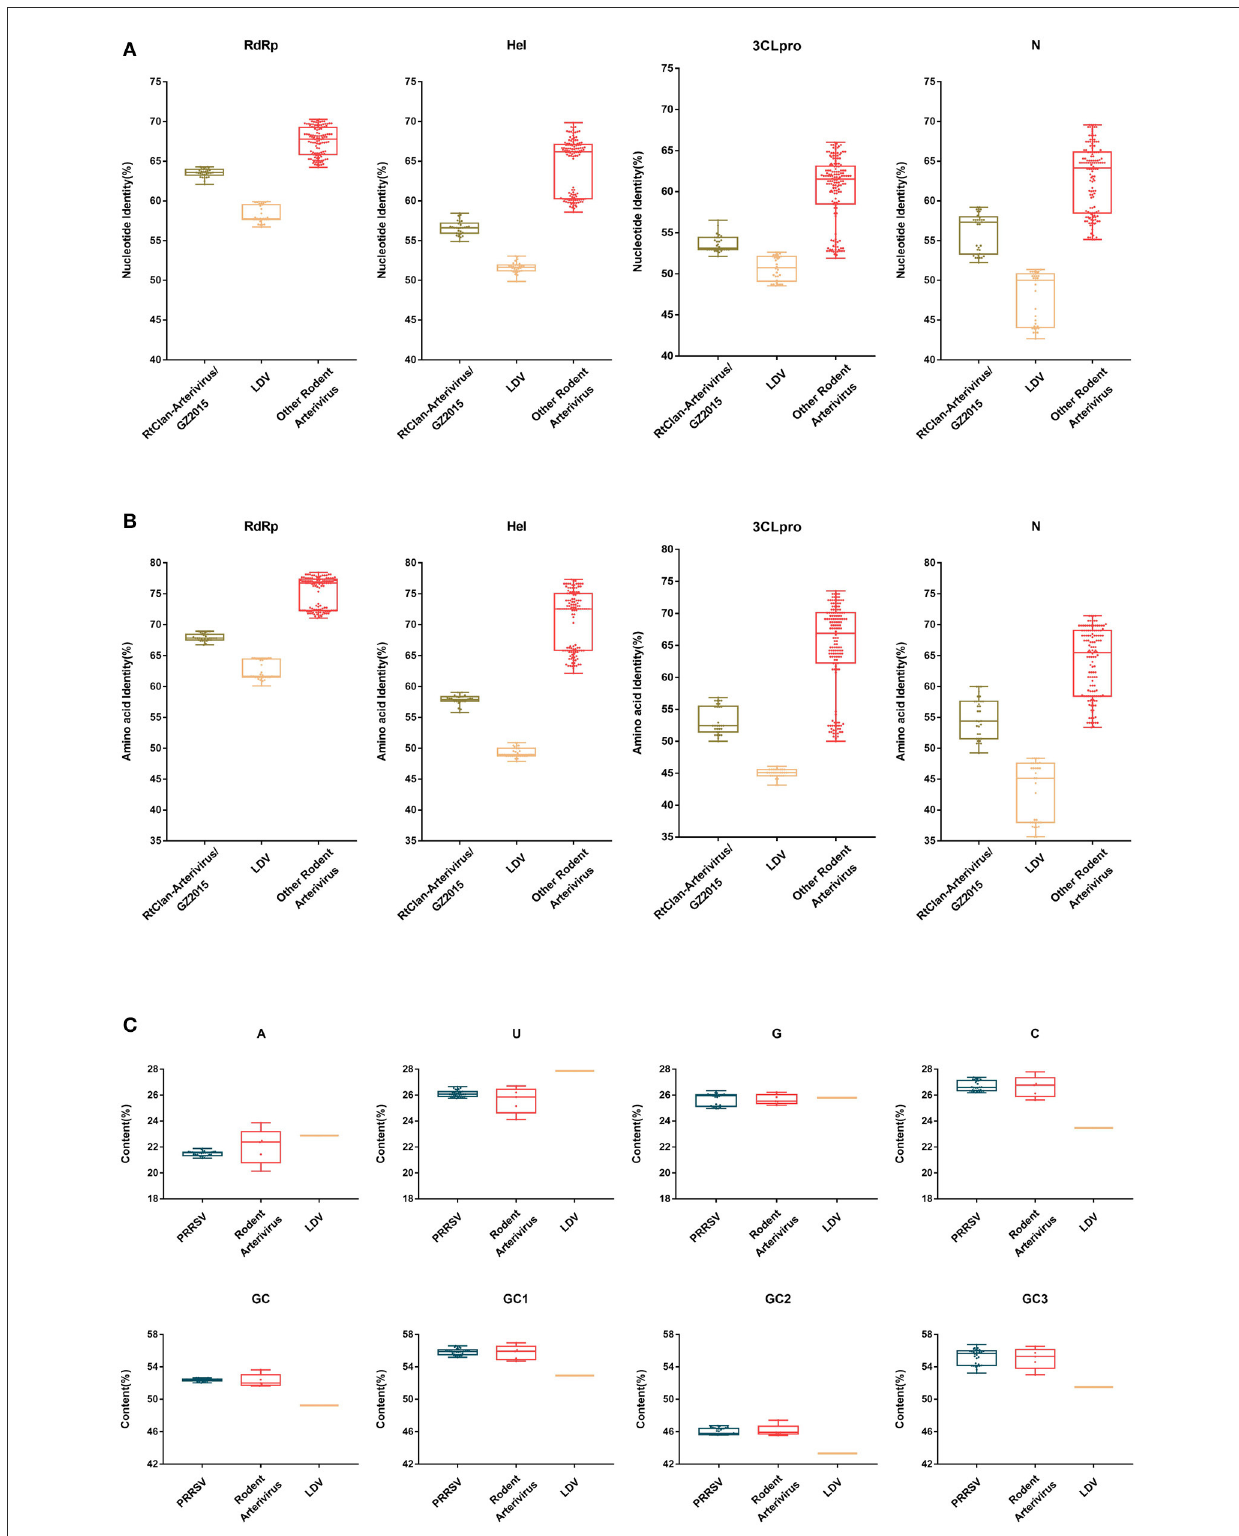
FIGURE7 Nucleotide, amino acid identity and codon usage bias of PRRSV and rodent arterivirus. The nucleotide identity (A) and putative amino acid identity (B) compared to PRRSV of RNA-dependent RNA polymerase (RdRp), helicase (Hel), 3C-like protease (3CLpro) and nucleocapsid (N) genes were analyzed by BioAider v 1.314. The A%, U%, G%, C%, GC1, GC2, GC3, and GC of arterivirus (C) were calculated using the CAI calculator website (http://genomes. urv.es/CAIcal/). Each dot represents the corresponding value of each strain. The box size represents the interquartile range (IQR), which is equal to the difference between the upper quartile and the lower quartile. The middle horizontal line of the box represents the median of the